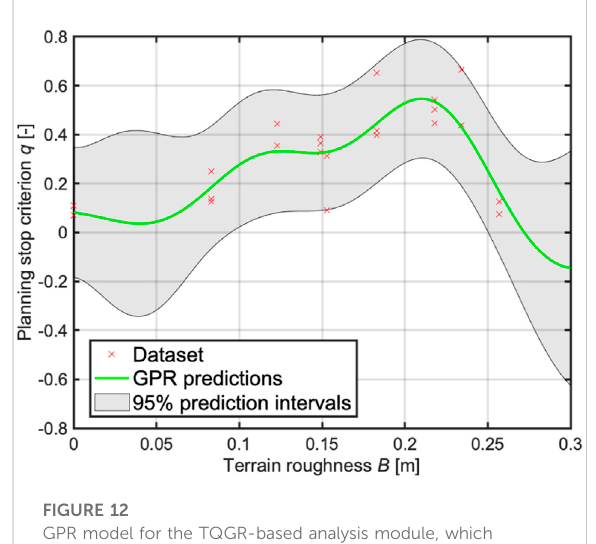
FIGURE 14 Time history of computational time vs. cost.